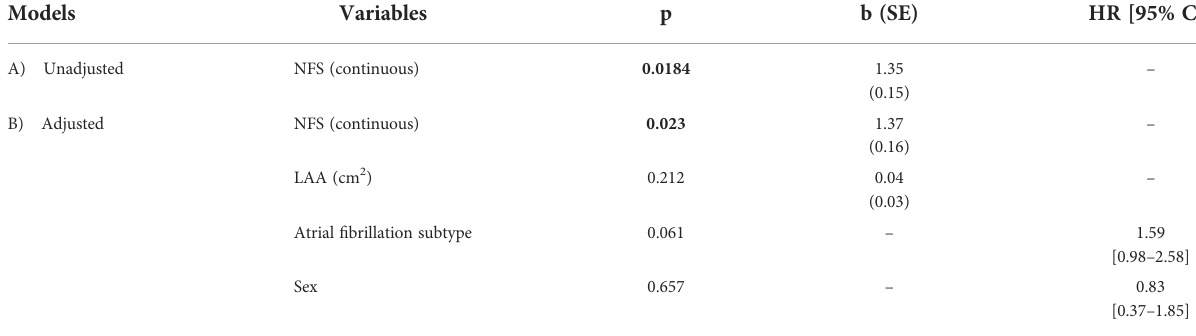
TABLE 3 Cox regression analysis of AF recurrence after